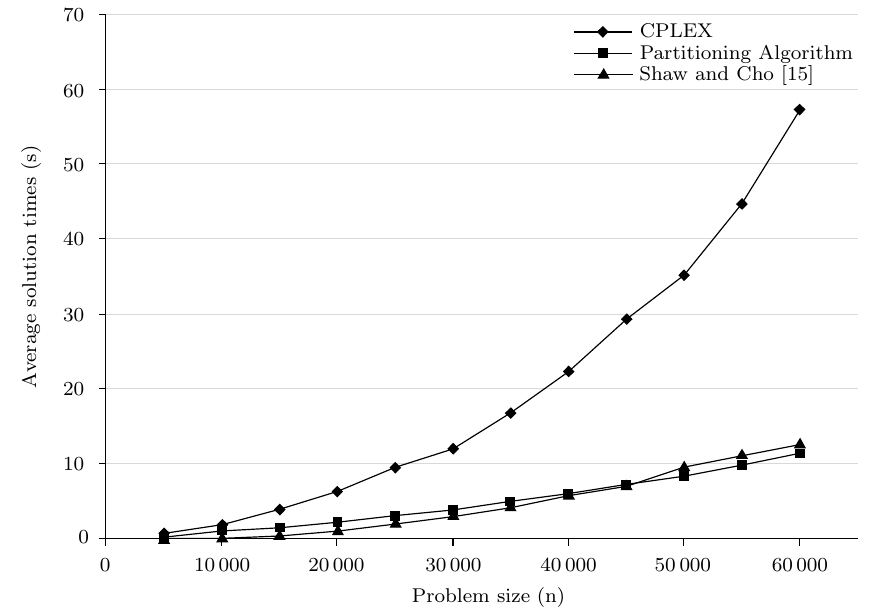
Figure 4: Average solution times for the subset sum data TKP